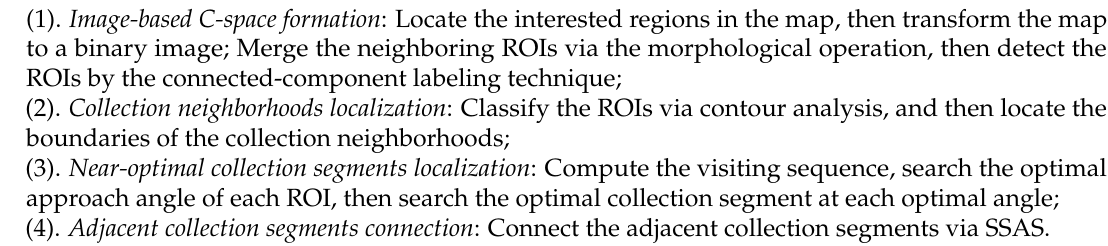
Algorithm 1 Overview of the Proposed Path